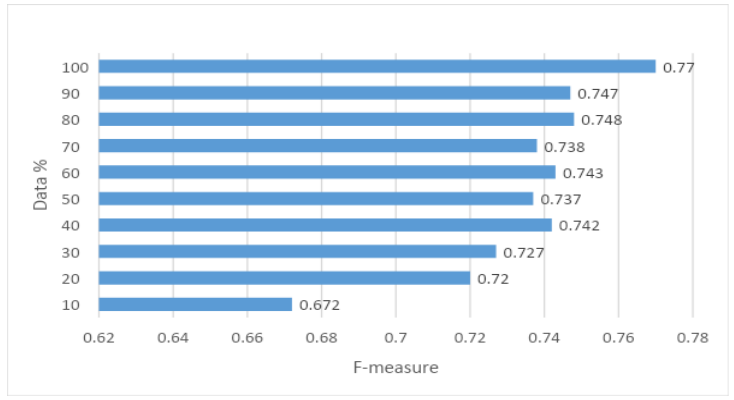
Figure 7. F ‐ measure for Bayesian Network with a random projection. Figure 7. F-measure for Bayesian Network with a random projection.